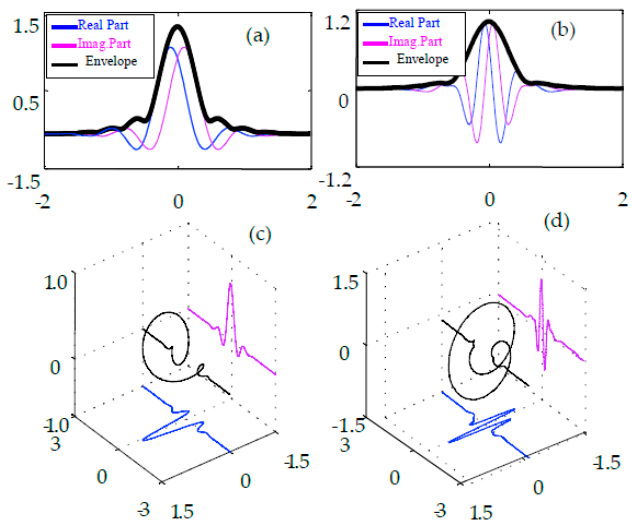
Figure 4. ( a ) Envelope of the complex scaling functions; ( b ) envelope of the complex wavelet functions; ( c ) three-dimensional (3D) plot of the complex wavelet functions and ( d ) 3D plot of the complex wavelet functions.